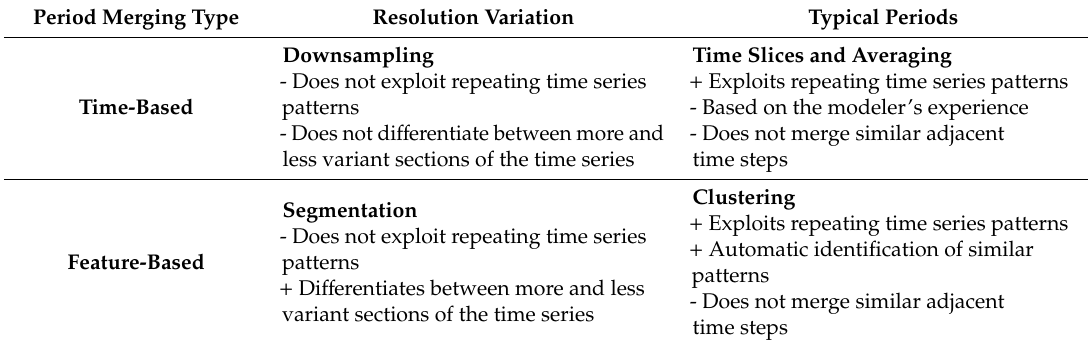
Table 4. Pros and cons of the presented major aggregation